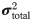
Variability of the active response.For the three worm types, in (A) we plot the total variance of velocity profiles σtotal2. Note that these numbers depend strongly on the preprocessing of the data—in particular, smoothing of the velocity (with the 500 ms filter, Materials and Methods) decreases the total variance. In (B) we show the fraction of potentially explainable variance σI2/σtotal2. Finally, (C) shows the part of the explainable variance that was not explained by our statistical model σres2/σI2. See the main text for the discussion of the differences between the three worm types on this plot.